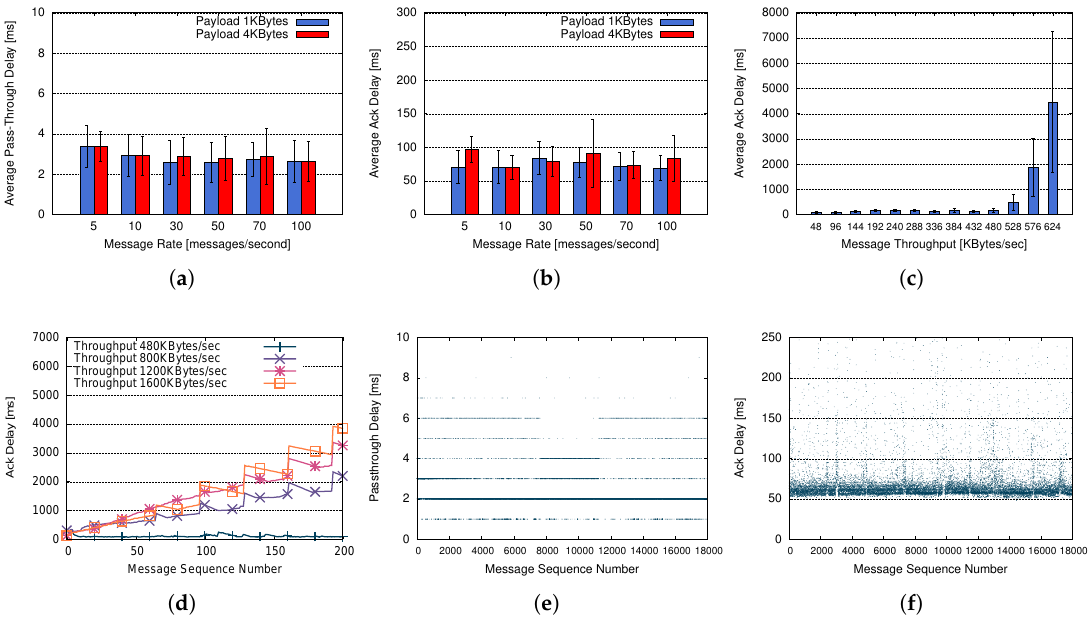
Figure 8. ( a ) Telemetry messages pass-through delay average; ( b ) telemetry messages ack delay average; ( c ) telemetry messages ack delay average; ( d ) telemetry messages ack delay; ( e ) telemetry messages pass-through delays; ( f ) telemetry messages ack